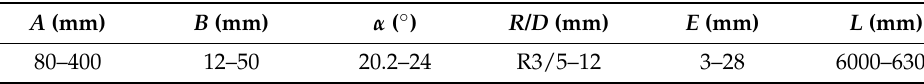
Figure 2. Basic dimension of steel raking blade. Table 1. Basic dimension of steel raking blade [23].